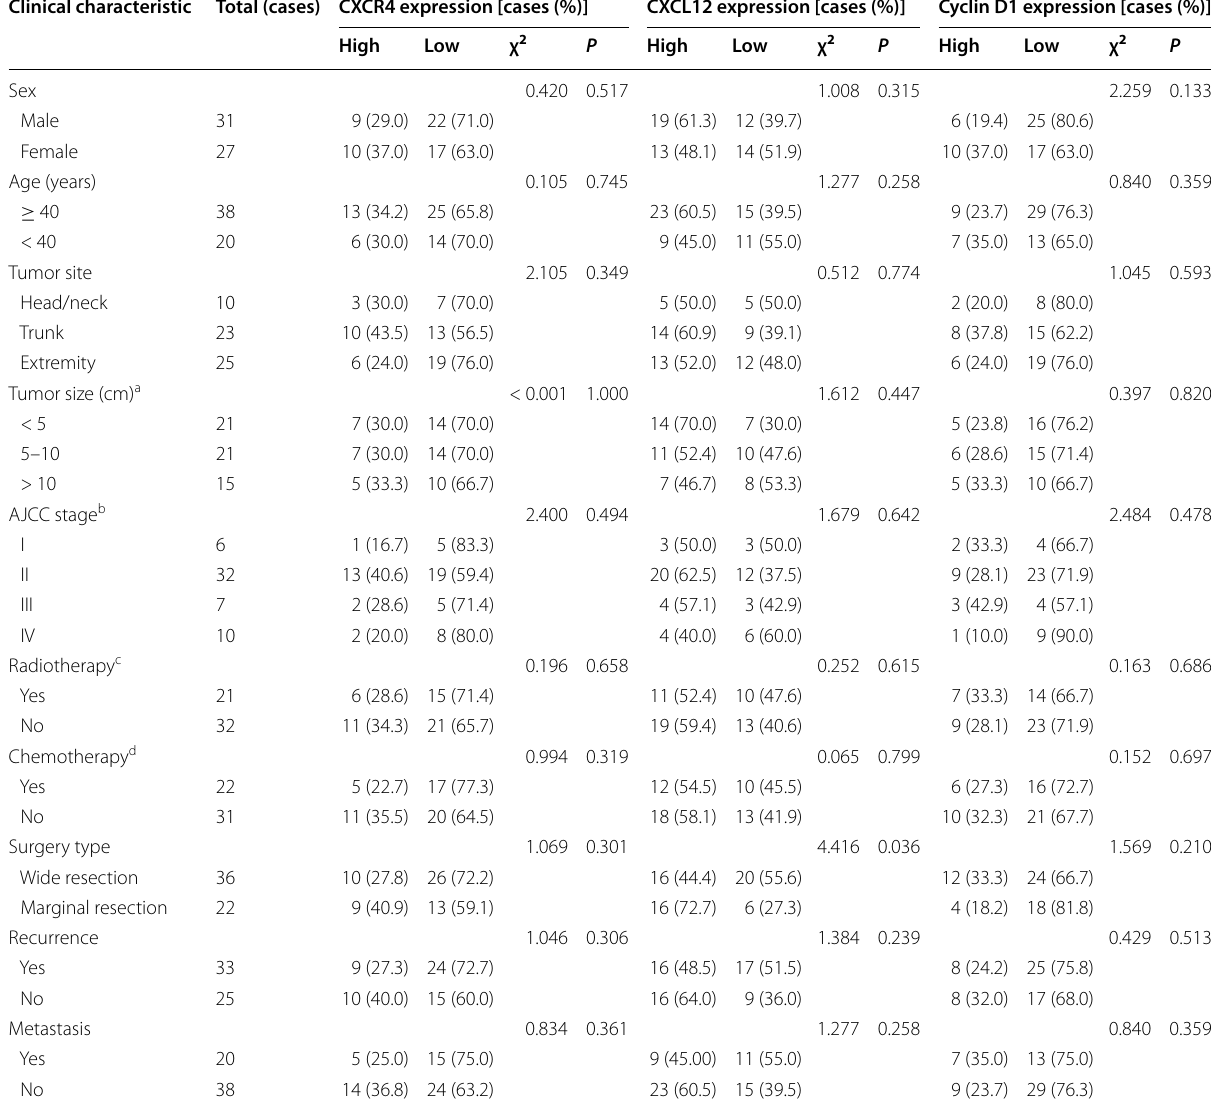
Table 1 Relationships between CXCR4, CXCL12, and Cyclin D1 expression levels and clinicopathologic characteristics of sporadic MPNST